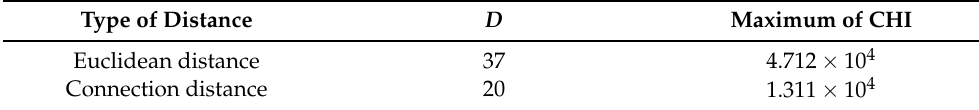
Table 1. The optimal parameter D in